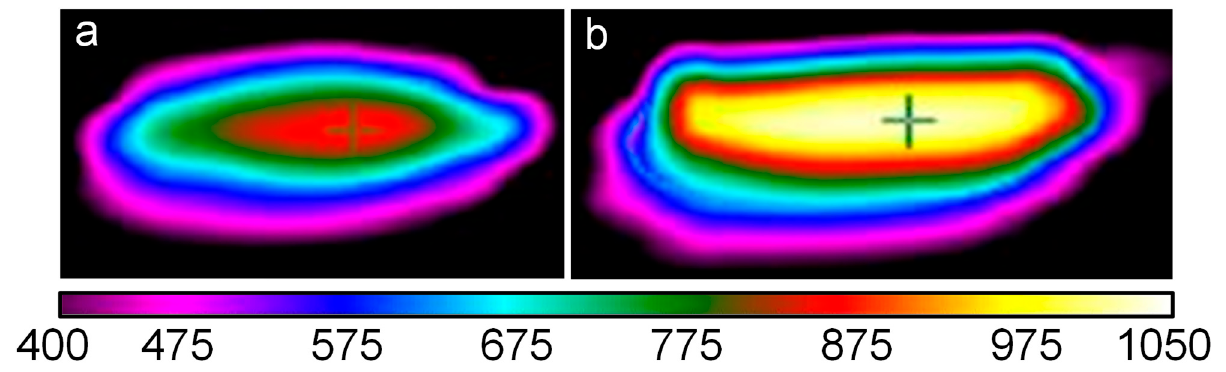
Figure 5. Thermal camera temperature maps at the joint interface of the CPM 15V tool steel to the shovel-tooth steel that were recorded at the onset of the forging stage where the maximum temper- ature occurred for the ( a ) LF and ( b ) HF conditions, respectively